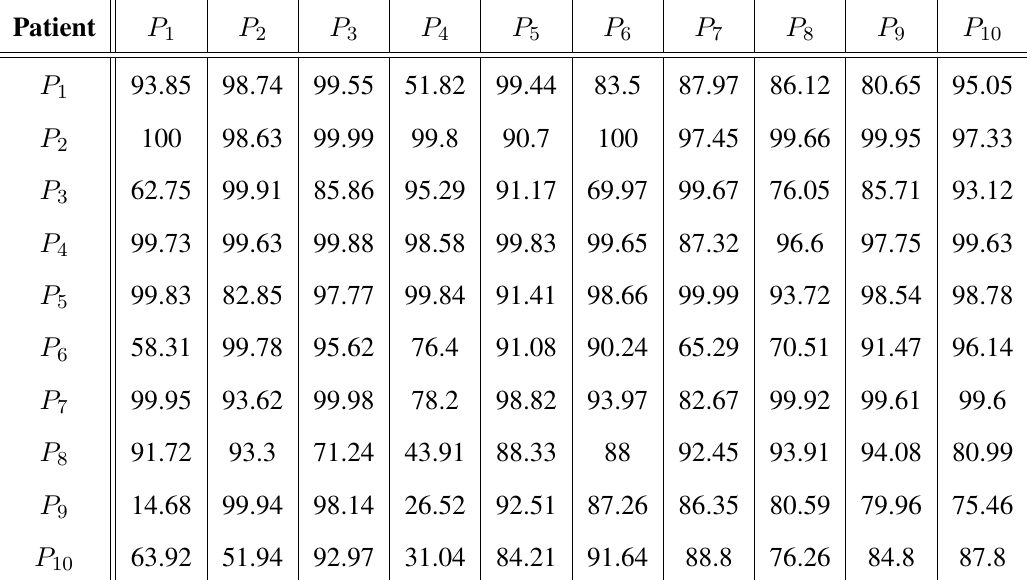
Table 3. Neural network results on validation